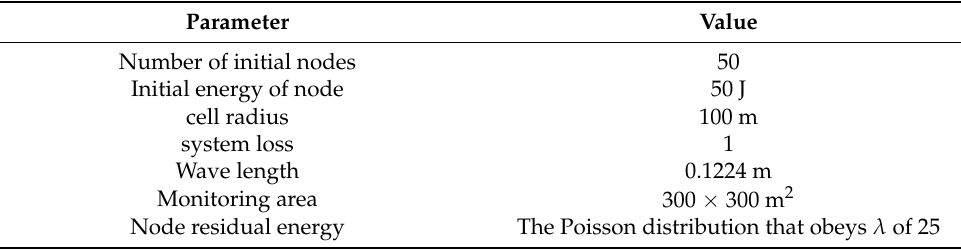
Table 1. Simulation parameters.